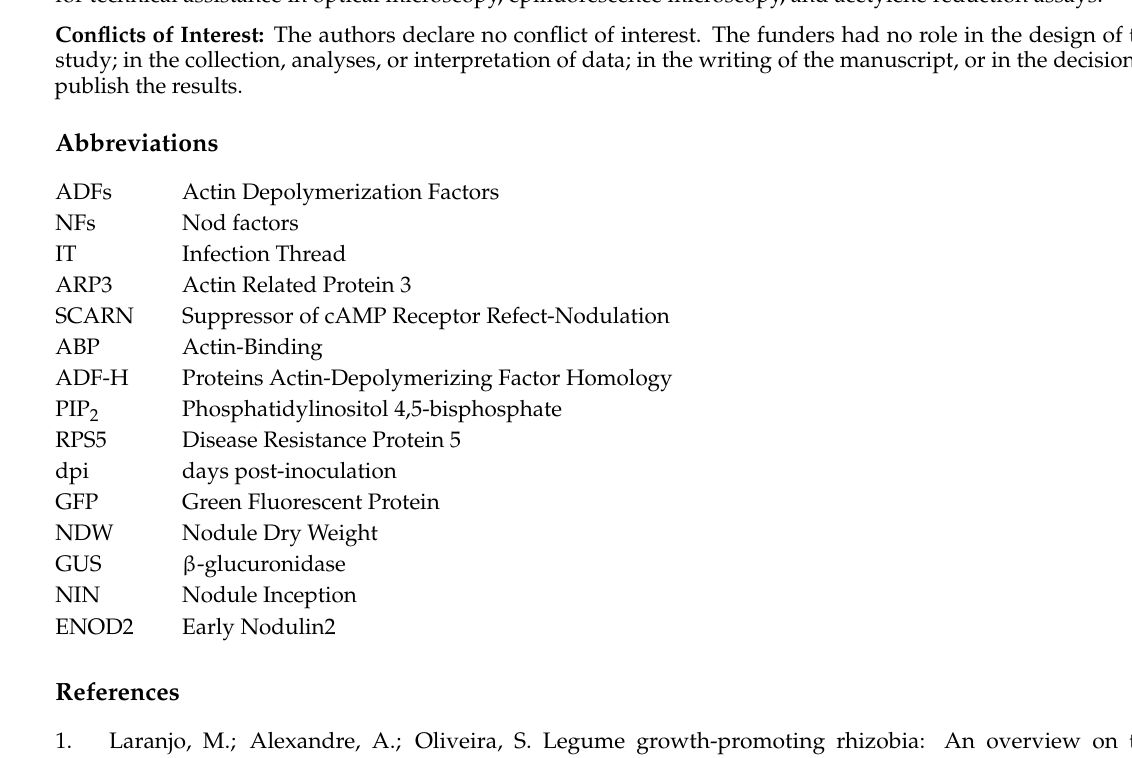
Figure S6. Reverse-transcription quantitative PCR analysis of PvADFE silencing in composite common beans roots; Figure S7. Expression of PvADF genes in control and PvADFE -RNAi transgenic roots at 10 days post emergence; Figure S8. Nodule diameters on PvADFE -RNAi and control transgenic roots after inoculation with R. tropici expressing GUS; Figure S9. Reverse-transcription quantitative PCR analysis of PvADFE overexpression in composite common bean roots; Figure S10. Nodule diameters on PvADFE -OE and control transgenic roots after inoculation with R. tropici expressing GUS; Figure S11. In silico map of the pH7WG2tdT vector; Table S1. Size of the ADF gene family in various plants; Table S2. Percentage of nucleotide sequence identity among P. vulgaris ADF genes; Table S3. Percentage of amino acid sequence identity between PvADF and AthADF proteins; Table S4. Annotation of ADFs aminoacid sequences used for the phylogenetic analysis; Table S5. Gene specific oligonucleotides